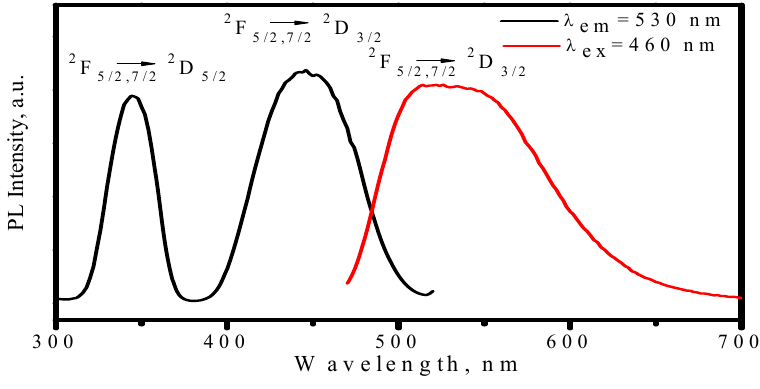
= 530 nm) and emission ( λ Figure 17. Excitation ( λ em (Lu Ce ) Al O phosphor. 0.9 0.01 3 5 13